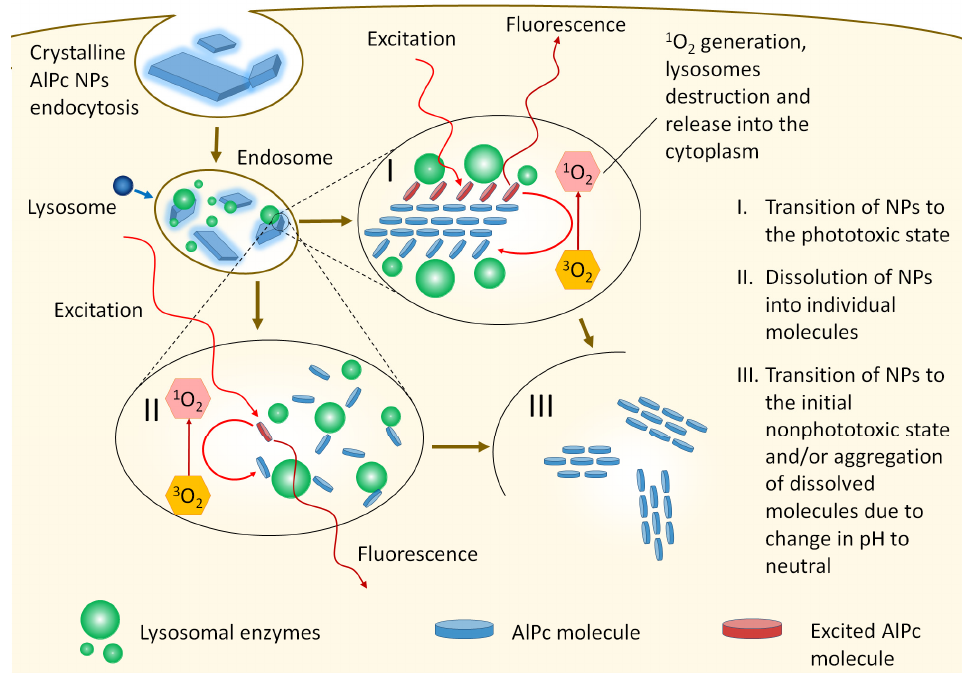
Figure 8. Model of the fluorescence and phototoxicity mechanism of AlPc NPs captured by cells.